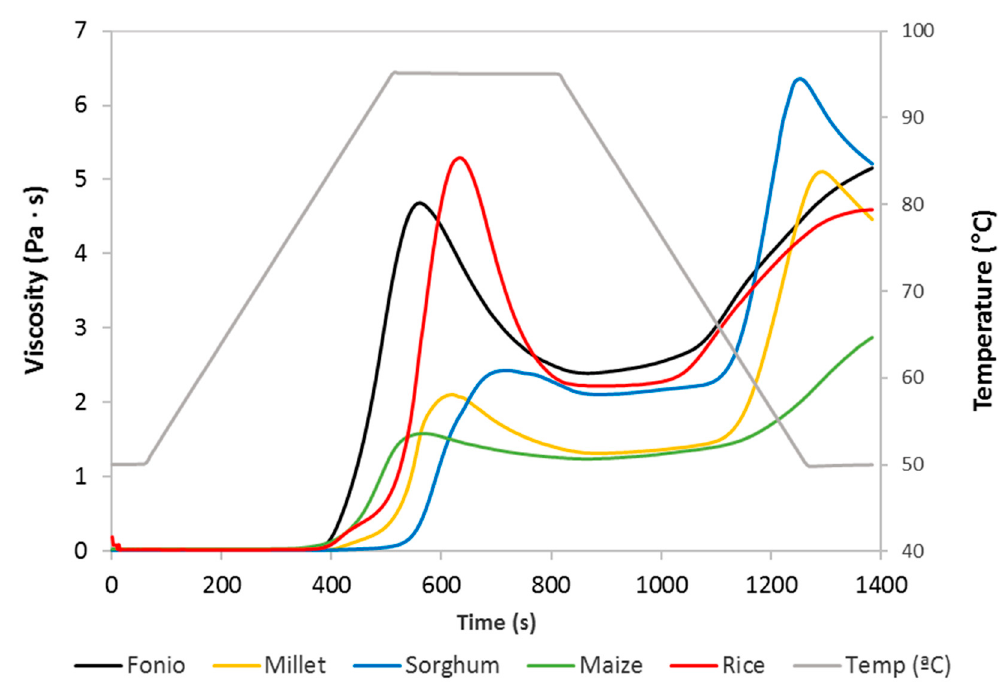
Figure 1. Pasting properties of the gluten-free flours